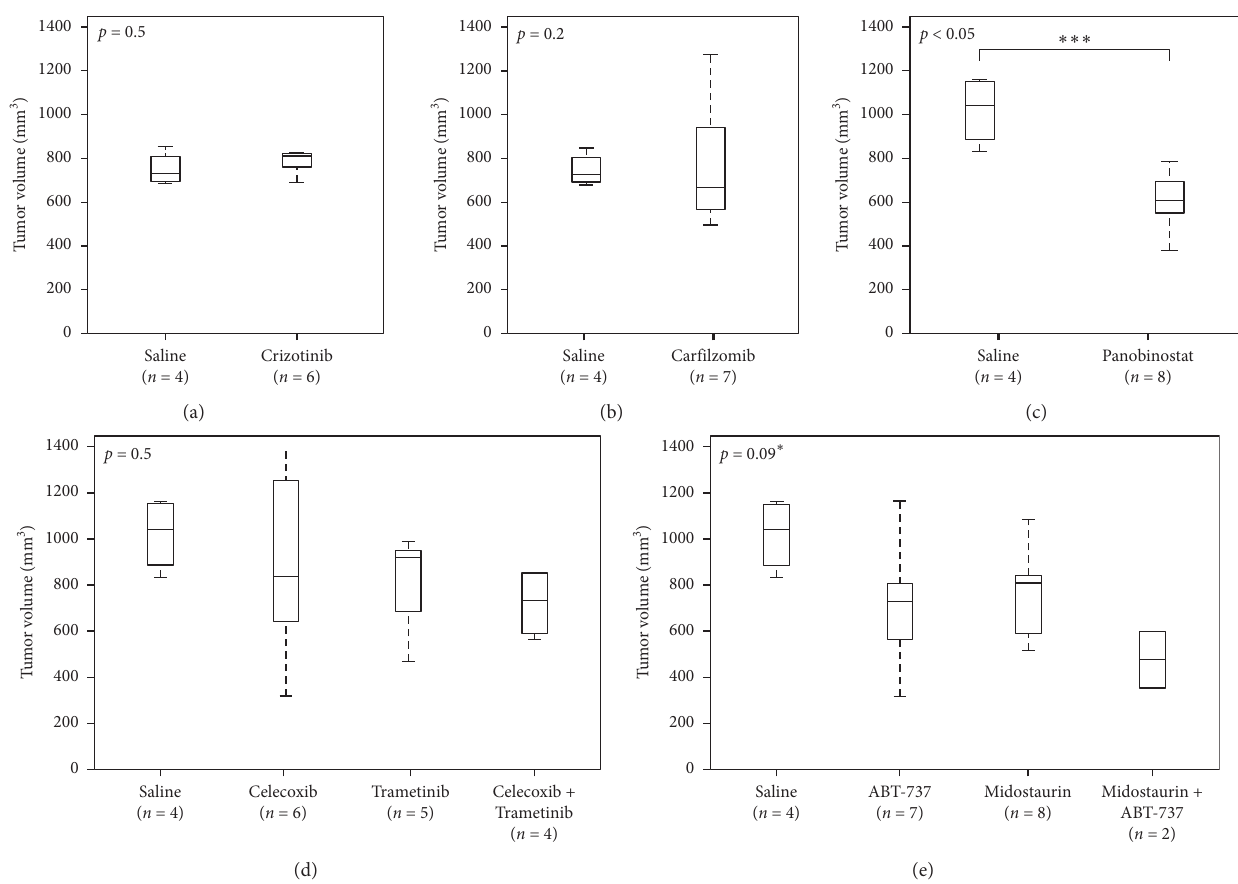
Figure 4: PCB-209 xenograft-derived in vivo trial results. Mean tumor volume of all treatment cohorts of the Jackson Lab-based PCB-209 patient-derived xenograft (PDX) model in vivo preclinical studies. (a) Tumor growth of crizotinib-treated PDX mice ( n � 6) versus control ( n � 4). (b) Tumor growth of carfilzomib-treated PDX mice ( n � 7) versus control ( n � 4). (c) Tumor growth of panobinostat-treated PDX mice ( n � 8) versus control ( n � 4). (d) Tumor growth of celecoxib- ( n � 5), trametinib- ( n � 5), and celecoxib+ trametinib-treated ( n � 4) PDX mice versus control ( n � 4). (e) Tumor growth of ABT-737 ( n � 7), midostaurin ( n � 8), and ABT-737 +midostaurin-treated PDX mice ( n � 2) versus control ( n � 4). The p value was calculated without the midostaurin +ABT-737 due to low sample population, noted by the asterisk. The low number of models for the combination experiment is due to microbiological considerations at the Jackson Laboratory. In (a–e), the endpoint was treatment days